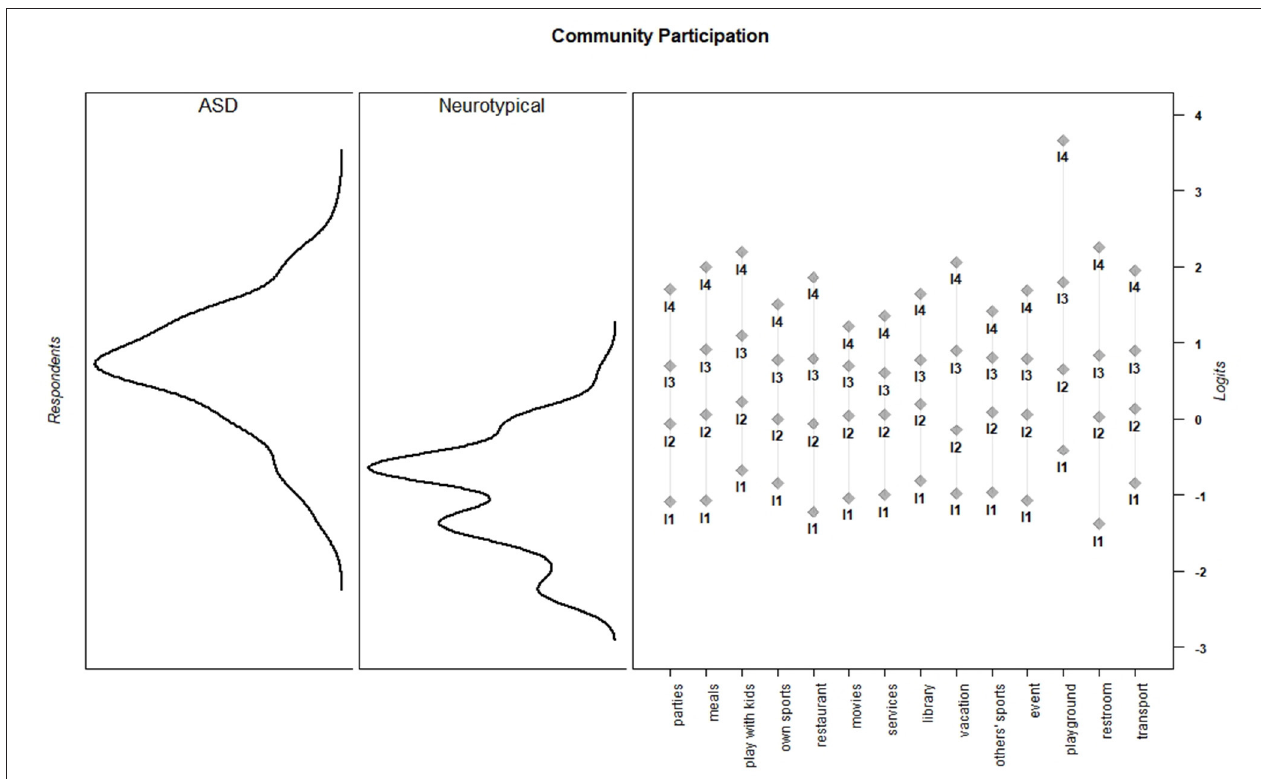
FIGURE 5 | Community participation item parameters and person parameters by